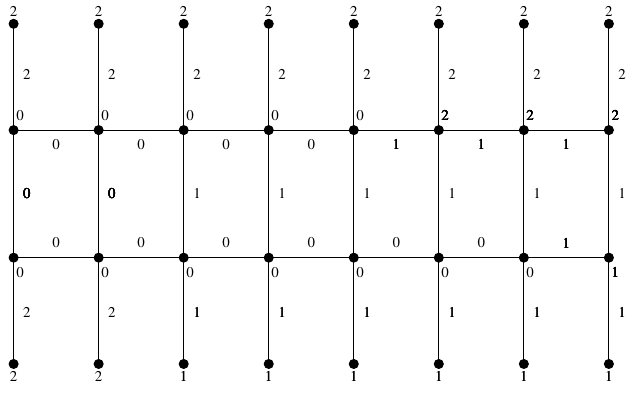
Fig. 16 3-TEPC labeling of graph L 8 (cid:12) 2 K